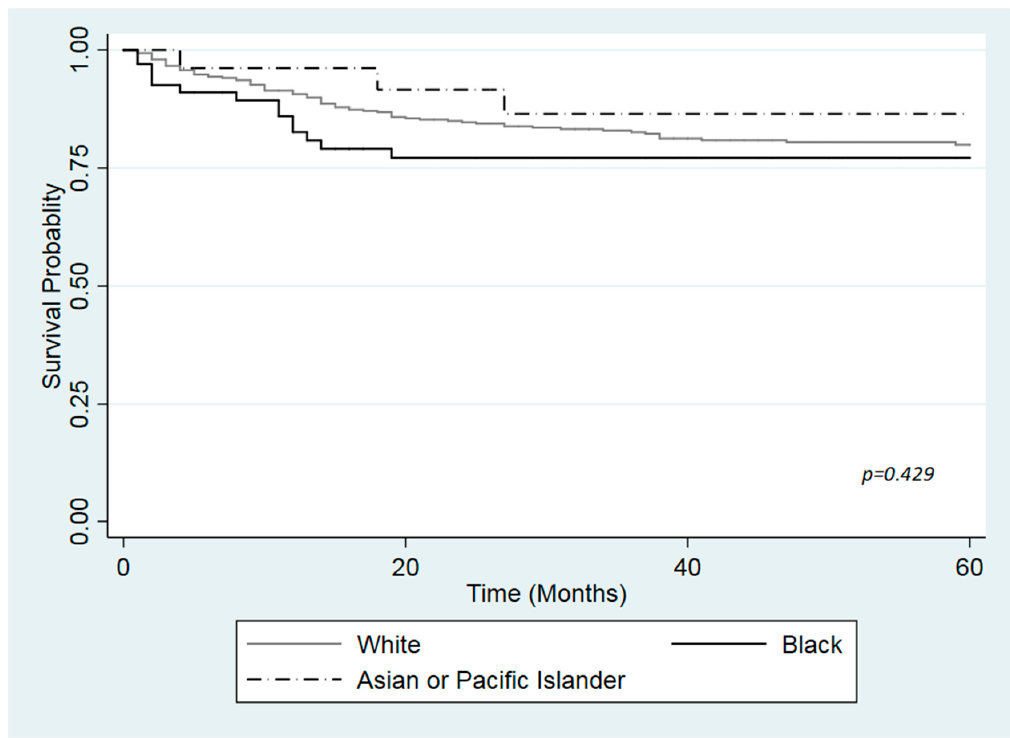
Figure 3. Kaplan-Meier curve for cause specific survival by race among uninsured patients with urinary bladder cancer, based on the SEER cohort, 2007–2015.